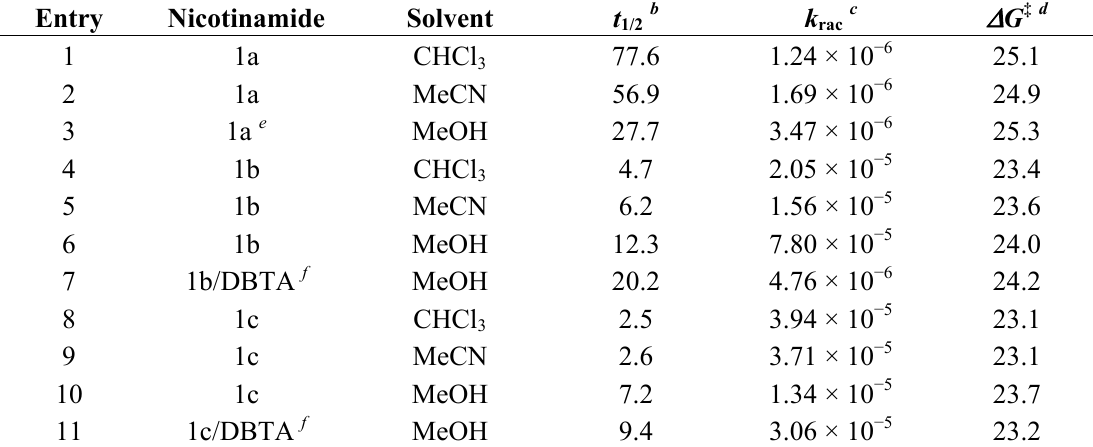
Table 2. Activation parameters for racemization of 1a – c under various conditions a